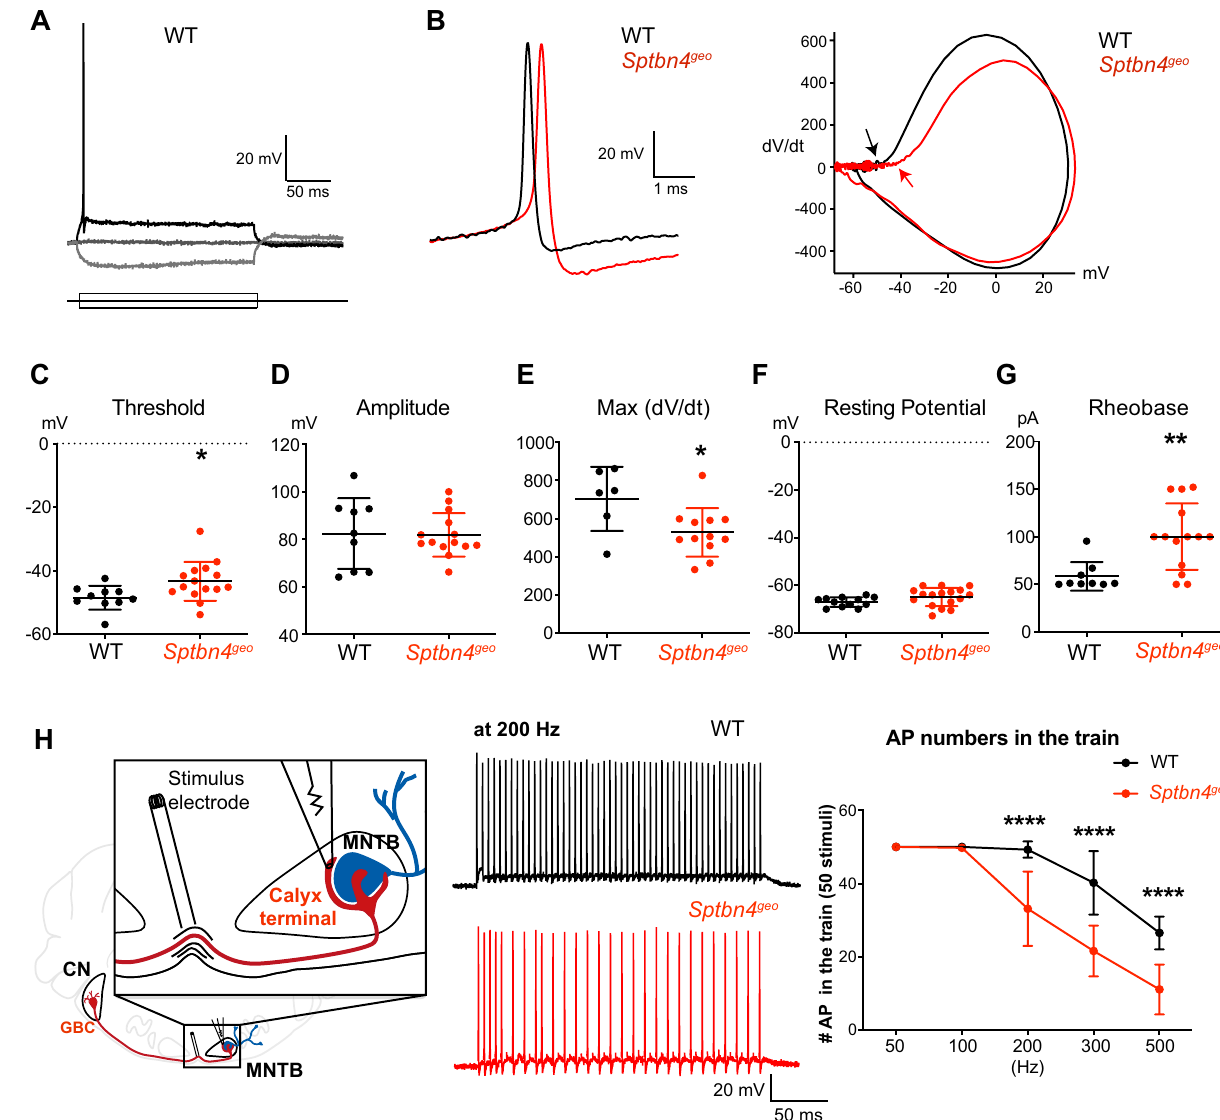
Figure 3. Loss of β4-spectrin reduces presynaptic excitability and increased AP failures at the nerve terminal during high-frequency stimuli. ( A ) Membrane potential changes of the calyx terminal in response to step- like current injection (− 50 to 50 pA) in whole-cell patch clamp recording in WT mouse. ( B ) Presynaptic APs elicited with a supra-threshold current injection and their corresponding phase plots (dV/dt against membrane potential) in WT (black) and Sptbn4 geo (red) mice. Arrows indicate the threshold of APs. ( C–G ) Summary of AP threshold and amplitude, the max dV/dt, the resting potential, and rheobase at the calyx terminal. The threshold of AP was determined by the point where dV/dt exceeds 10 V/s and the amplitude of AP from the threshold to the AP peak in the phase plot. ( H ) (Left) Diagram for presynaptic recording from the calyx of Held terminal in response to fiber stimulation placed at the midline of the brainstem. CN, cochlear nucleus,GBC, globular bushy cell, and MNTB, medial nucleus of the trapezoid body. (Middle) Representative traces of presynaptic AP train elicited with afferent axon fiber stimuli (at 200 Hz) in WT (black) and Sptbn4 geo (red). (Right) Summary of the number of APs in the train (50 stimuli) as a function of fiber stimuli frequencies (50 Hz to 500 Hz). values are means ± S.D. (* p < 0.05, ** p < 0.01, **** p < 0.0001, Mann–Whitney U test or Two-way